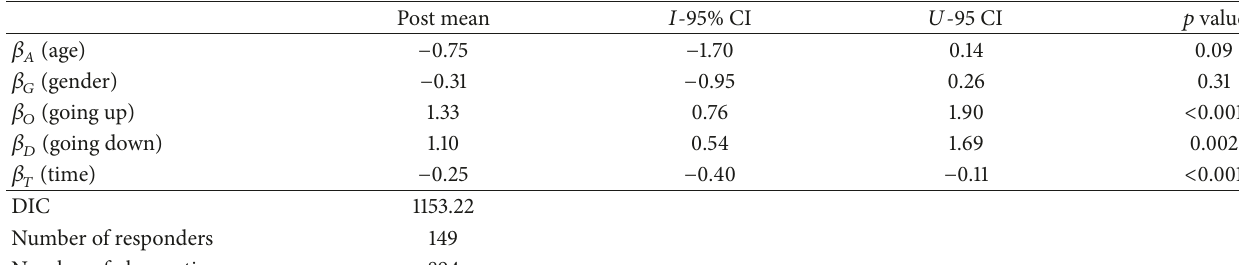
Table 6: Estimated result for the multilevel logistic model.